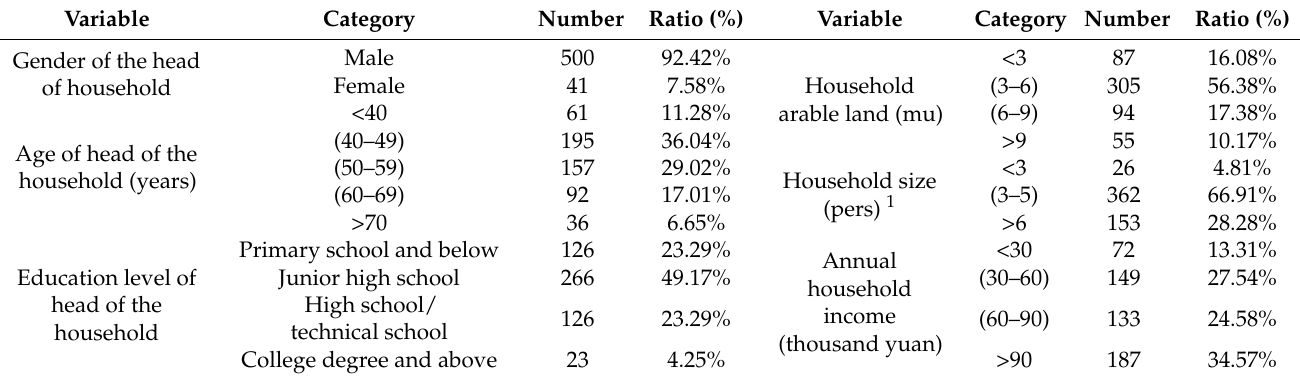
Table A2. Household information of sample farmers in the survey